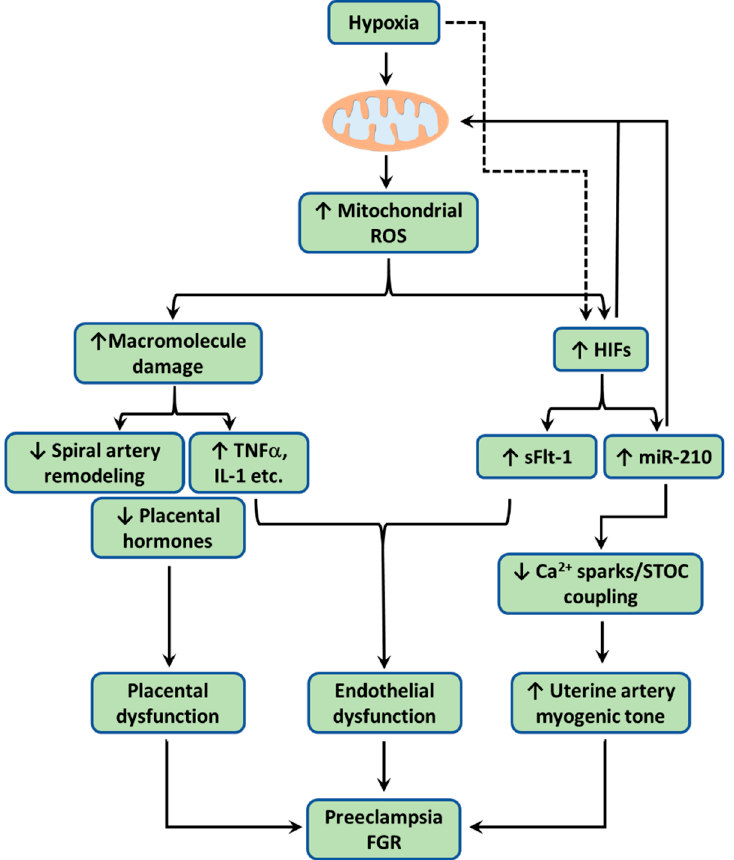
Figure 2. When the uteroplacental cells encounter hypoxia, mitochondria overproduce reactive oxygen species (ROS). Excess ROS cause lipid peroxidation, protein carbonyl, and DNA damage, resulting mitochondrial dysfunction. Dysfunctional mitochondria engender placental dysfunction by (1) promoting trophoblast apoptosis, reducing trophoblast invasion, and consequently impairing spiral artery remodeling, (2) increasing production/release of pro-inflammatory cytokines including TNF α , IL-1 β , and IL-6, and (3) suppressing production/release of placental hormones including estrogen, chorionic gonadotropin (CG), and placental lactogen (PL). Hypoxia also via mitochondrial ROS stabilizes hypoxia inducible factors (HIFs), which induces the expression of microRNA-210 (miR-210) and soluble Fms-like tyrosine kinase-1 (sFlt-1). HIF-1 could also in turn reduces mitochondrial metabolism. Once released into the maternal circulation, both pro-inflammatory cytokines and sFlt-1 cause endothelial dysfunction and/or impaired angiogenesis. Pro-inflammatory cytokines and sFlt-1 also act via autocrine/paracrine signaling to disrupt placental function. HIF-responsive miR-210 acts on mitochondria to downregulate iron-sulfur cluster scaffold (ISCU) in the electron transport chain (ETC) to increase mitochondrial ROS. miR-210 suppresses the Ca 2+ spark/spontaneous transient outward current (STOC) coupling in uterine arteries directly or indirectly via miR-210-induced mitochondrial ROS, leading to increased arterial myogenic tone. Together, these changes conferred by hypoxia-induced mitochondrial ROS contribute to the pathogenesis of preeclampsia and FGR.